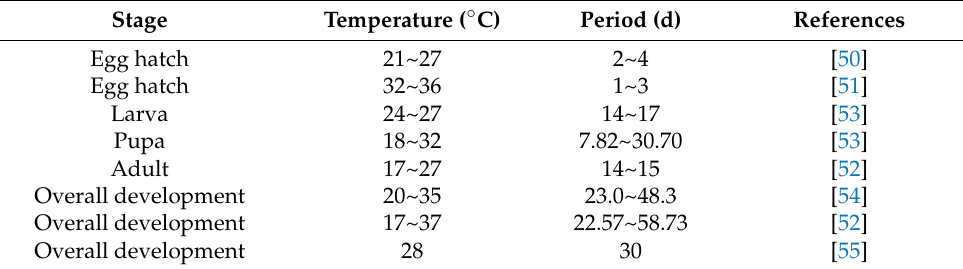
Table 1. Developmental periods of FAW at various